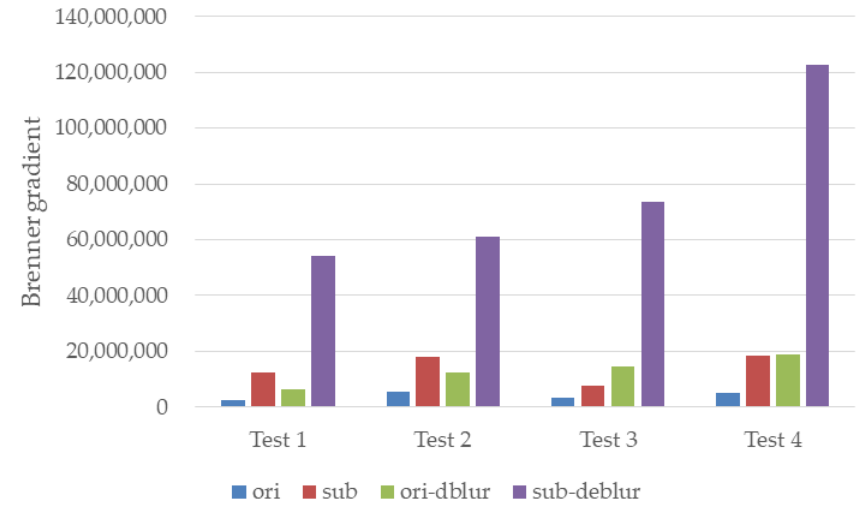
Figure 11. Comparison of images from Figure 10 by the Brenner gradient.